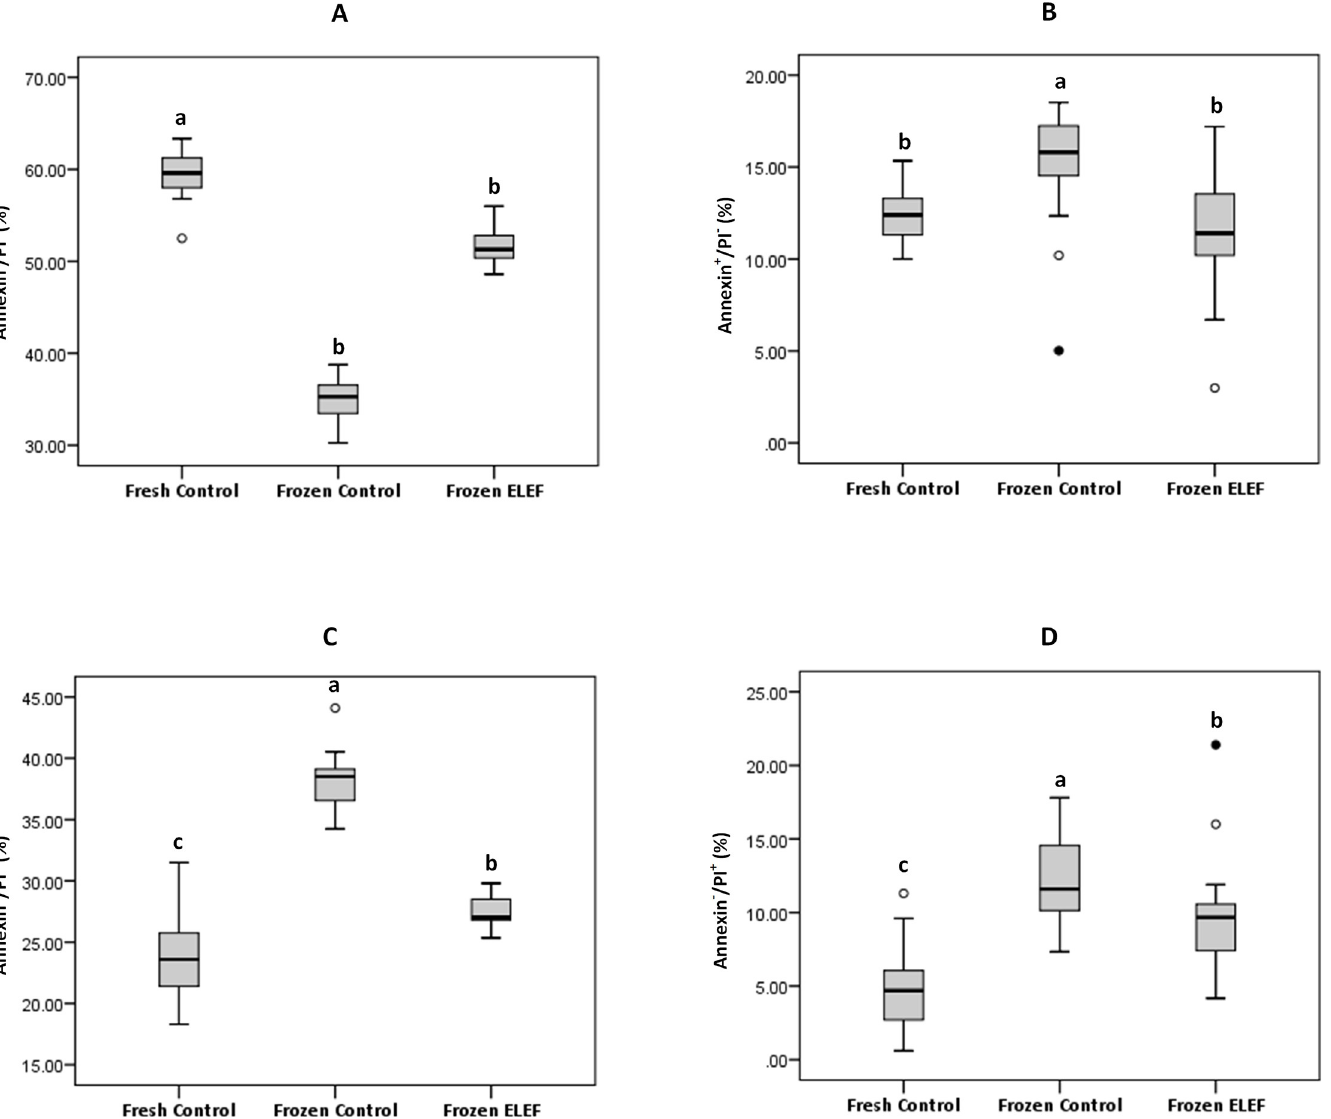
Fig 9. Box-and-whisker plots for (A) Annexin V - /PI - , (B) Annexin V + /PI - , (C) Annexin V + /PI + , and (D) Annexin V - /PI + staining of sperm to determine the different cell populations. The box and whisker plots show the median to interquartile ranges. Lower and upper whiskers represent 5th and 95th percentiles, respectively. The boxes represent the 25th and 75th percentiles. The assigned letters of a, b and c indicate significant differences (p < 0.05) among the groups. Values are expressed as mean ±